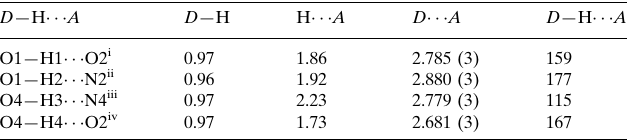
Hydrogen-bond geometry (A˚ , (cid:4)